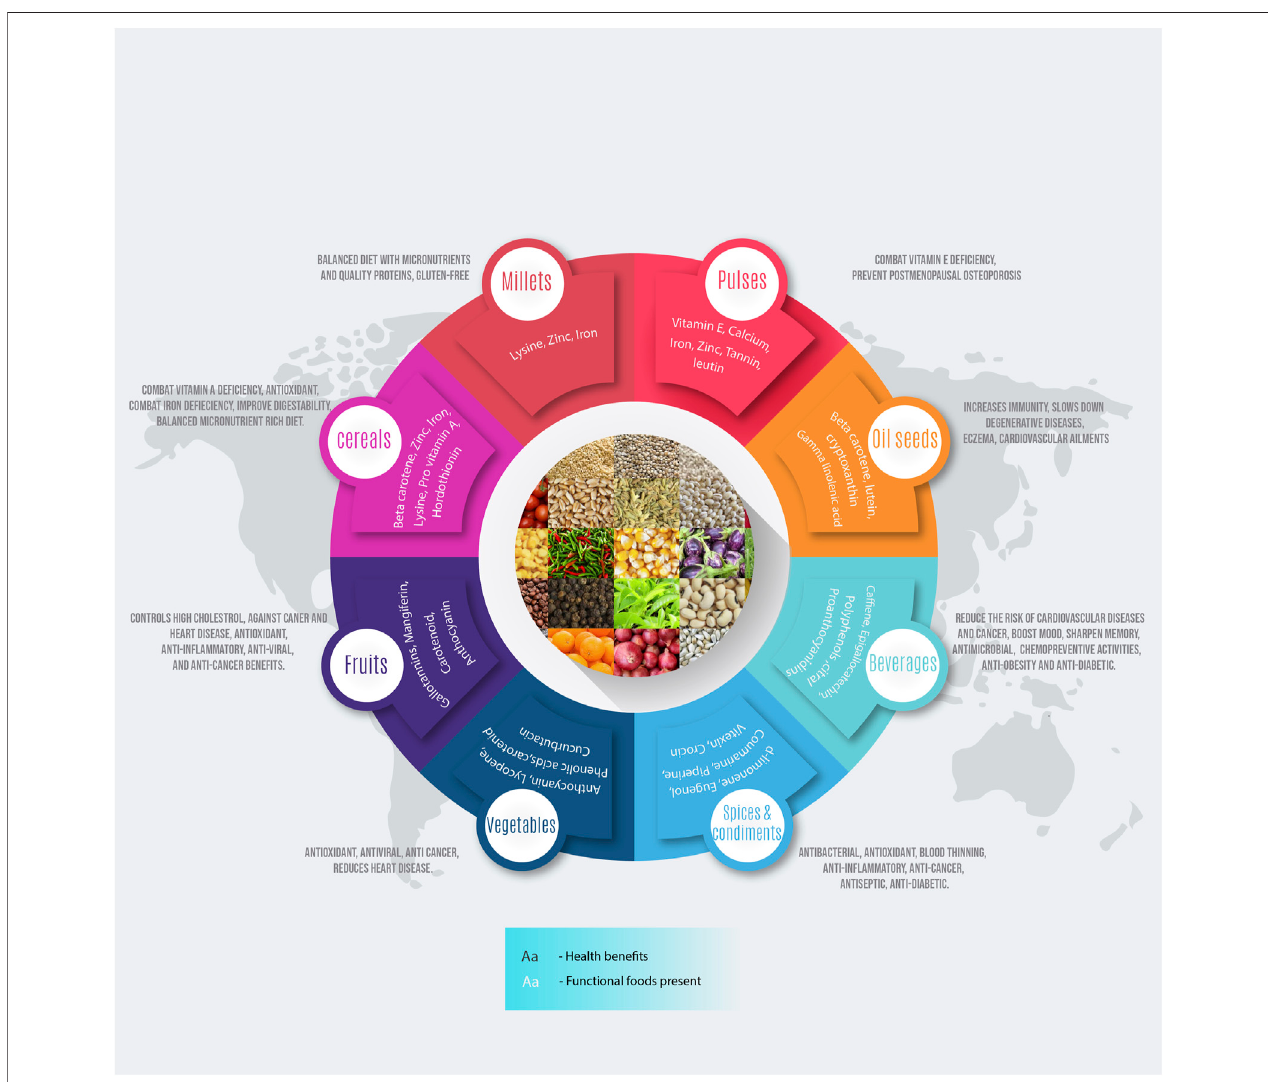
FIGURE 1 | An infographics showing the functional components of the food and their potential health bene fi ts to human beings.